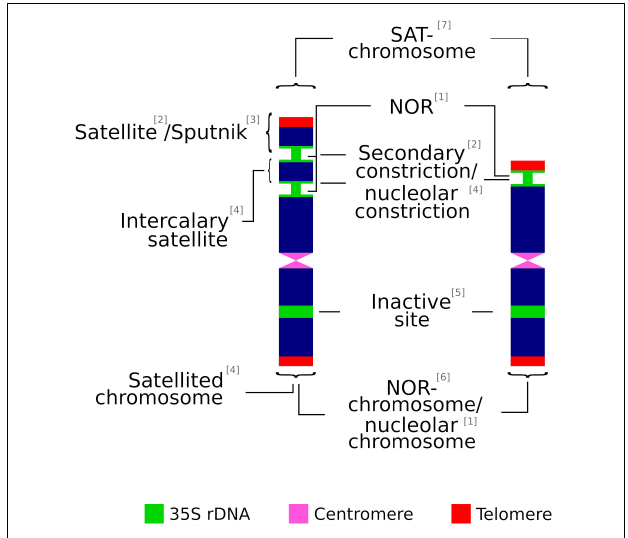
FIGURE 1 | Graphical summary of terms used to describe the chromosomic domains associated to the 35S rDNA locus. (1) McClintock, 1934; (2) Darlington, 1926; (3) Battaglia, 1999; (4) Battaglia, 1955; (5) Leitch and Heslop-Harrison, 1993; (6) Schwarzacher and Wachtler, 1983; (7) Heitz, 1931.